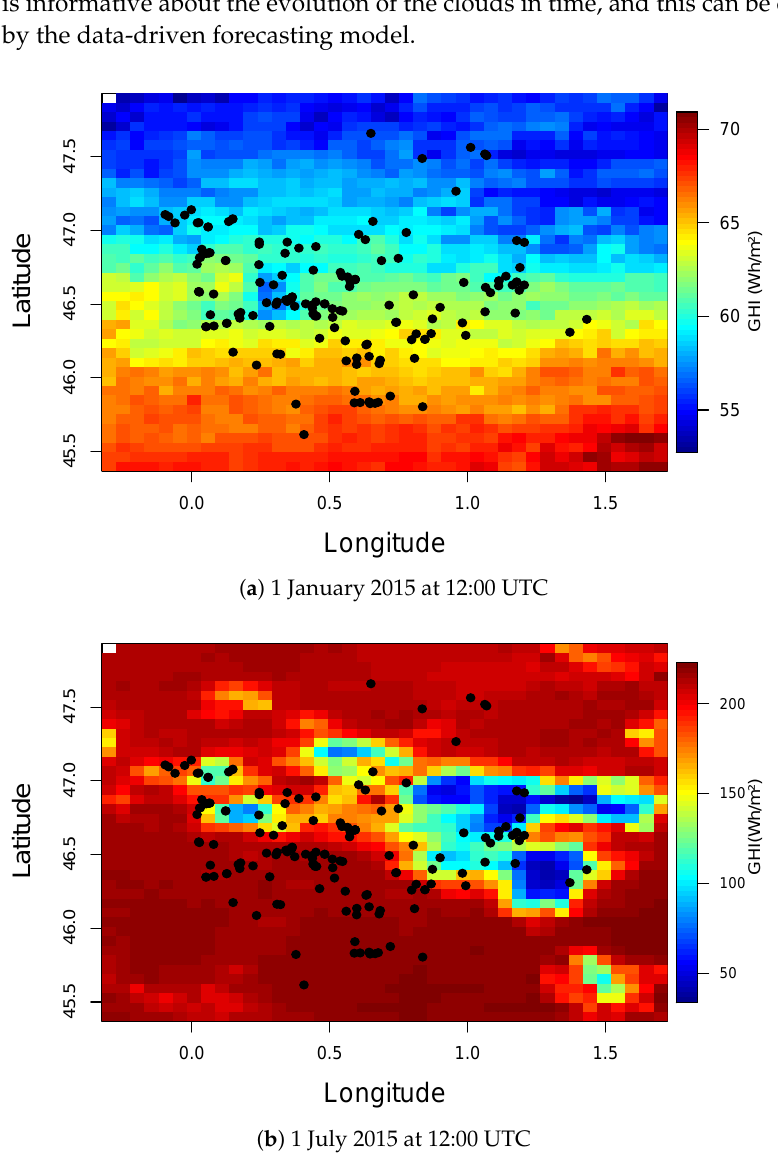
Figure 2. GHI from satellite data covering the power plants of data set d . The black dots represent the power